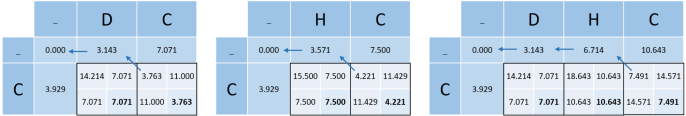
Example of feature five.